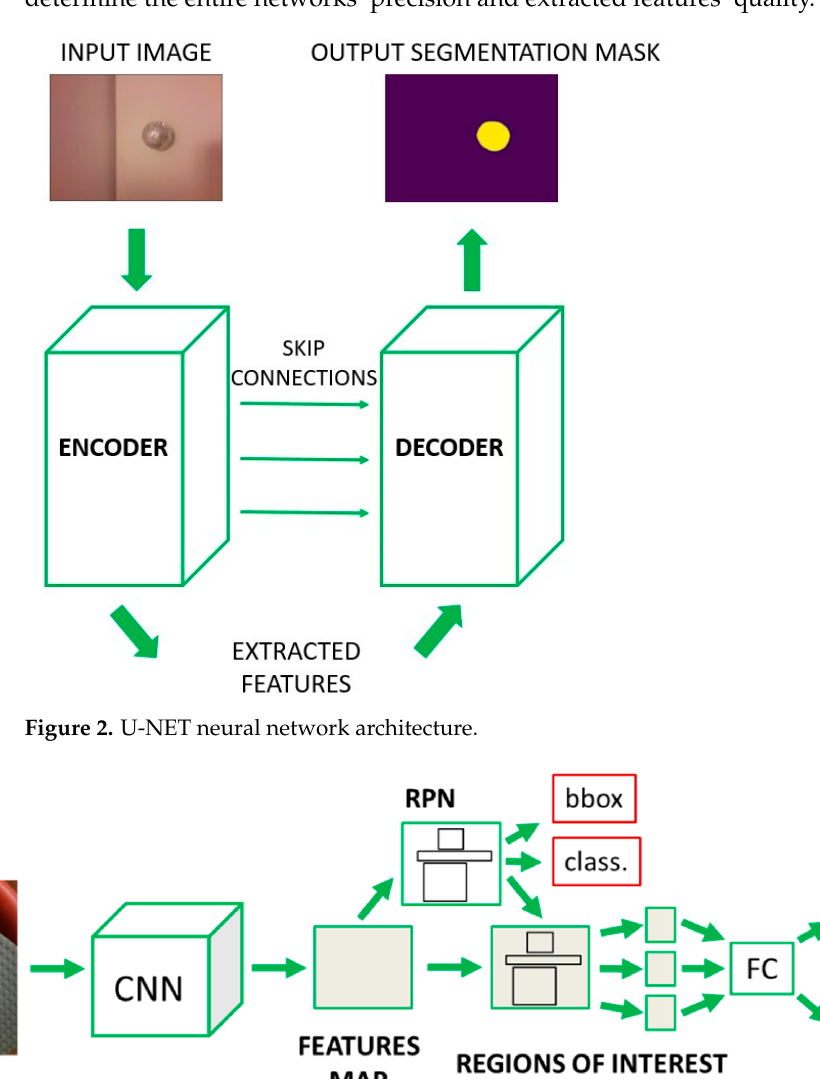
( c ) Figure 4. Annotation of images: ( a ) input (original) image, ( b ) annotation for semantic segmentation (red pixels) and ( c ) annotation for object detection (red bounding box). The fundamental challenge we were trying to solve was to fi nd a silver ball that was randomly placed inside the bounded area as in the RCJ competition [1]. Therefore, in or- der to recreate the problem as faithfully as possible, we made the balls of the same size as in the competition and wrapped them in aluminum foil to achieve a re fl ective silver sur- face. This re fl ective surface allowed us to eliminate the color as a feature when using tra- ditional computer vision algorithms and to mainly focus on the shape of a ball. Moreover, since this type of surface to some extent re fl ects the colors of its surroundings, it brings diversity to data during the training process of deep learning models. We took photos of balls in di ff erent light conditions and surroundings: in a dark room with li tt le or no light, under indoor lights of di ff erent intensities and temperatures (lights temperature range: 3000–5000 K), under daylight, with simple backgrounds and with col- orful surroundings full of details. Moreover, we applied random augmentation tech- niques during the neural network training process. We used augmentation techniques such as rotation, mirroring, luminance changes and optical distortion. Our main goal was to create robust models with good generalization features which would allow neural net- works to fi nd balls regardless of surroundings and light conditions. We also wanted to see how the quality of the training set impacts models’ predictions. Therefore, we created an additional test dataset by applying numerous augmentation techniques on random images, including those techniques that we did not use in the train- ing process, e.g., white noise addition and image blurring. We also annotated every image